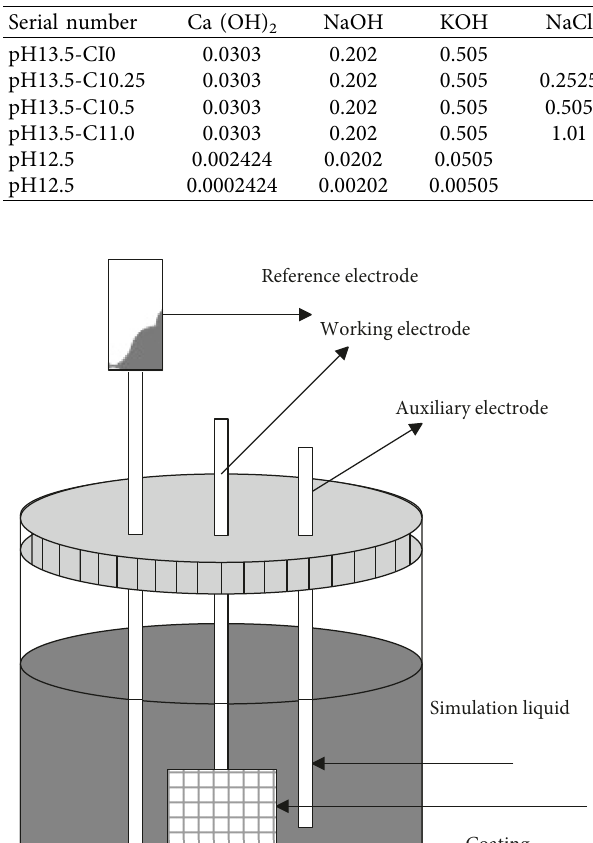
Table 10: Composition of simulated concrete pore solution (mol/L).